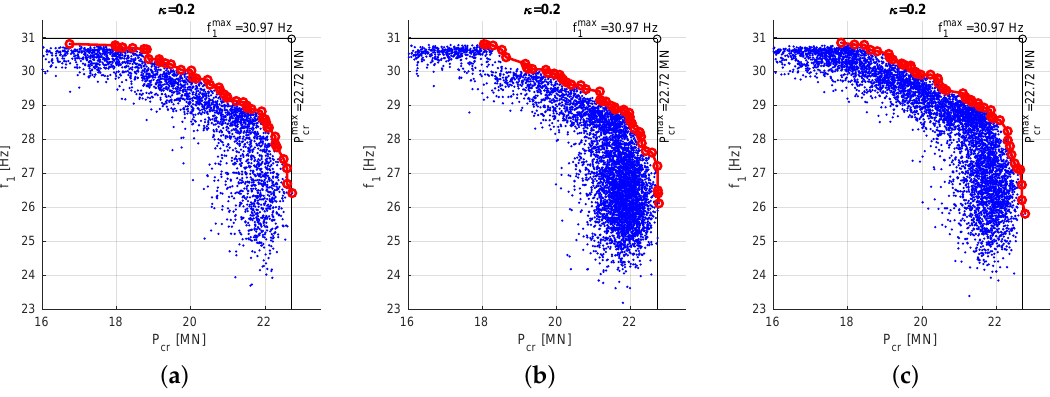
Figure 10. The envelope Pareto front, obtained for different values of coefficient α and constant κ = 0.2, = P 0 = 1, ( b ) f 0 ( a ) f 0 and P 0 cr obtained for Λ = [ 45/ − 45 ] 8 , ( c ) f 0 cr 1 1